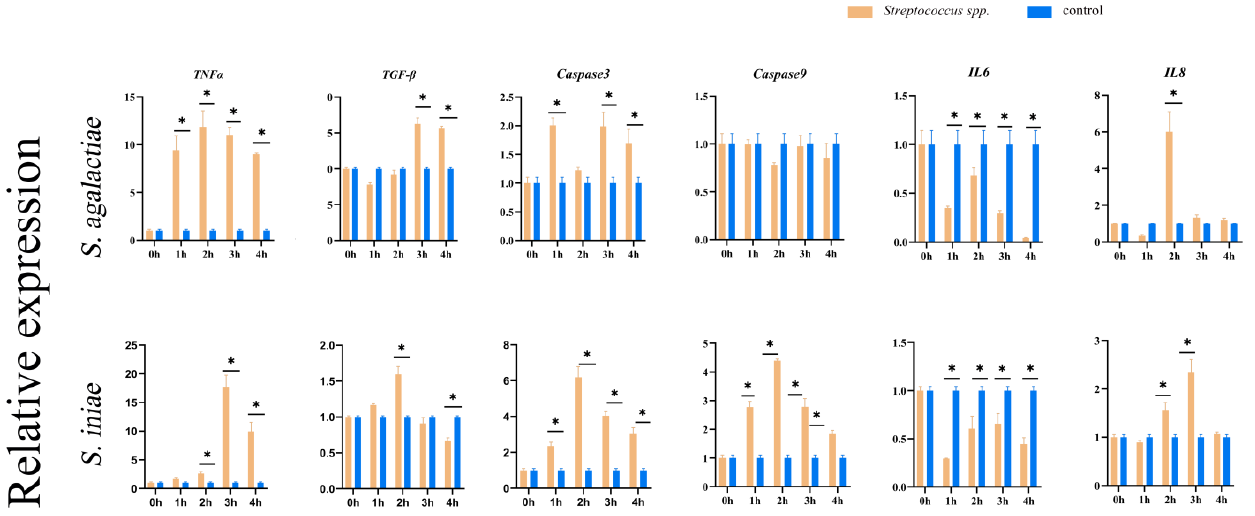
Figure 9. The expression patterns of immune-related gene expression ( TNF- α , TGF- β , Caspase3 , Caspase9 , IL-8 ) at various points after S. agalactiae and S. iniae infection via qRT-PCR. Every value is presented as the mean and standard deviation; n = 3. The asterisks reveal a significant difference ( p < 0.05).